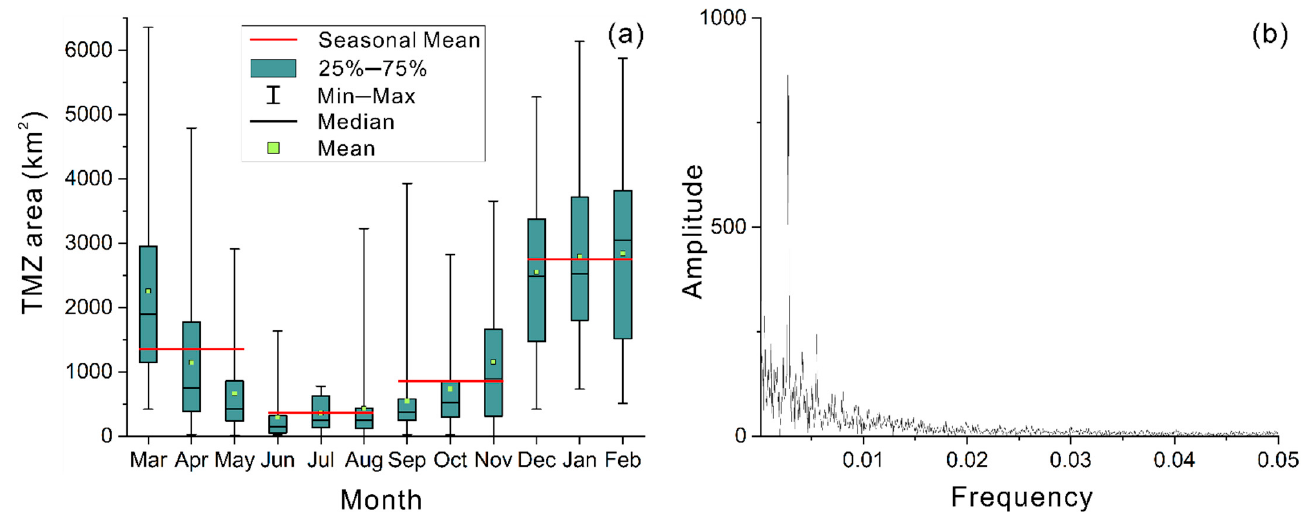
Figure 8. ( a ) Monthly statistics of TMZ area from 1984 to 2021. The spring, summer, autumn and winter seasonal TMZ area means are 1357 km 2 , 364 km 2 , 814 km 2 and 2730 km 2 , respectively. ( b ) Spectrum analysis of time series TMZ area from 1984 to 2021 through fast Fourier transform (FFT). The highest peak denotes the frequency of 0.0027, corresponding to 370-day period.